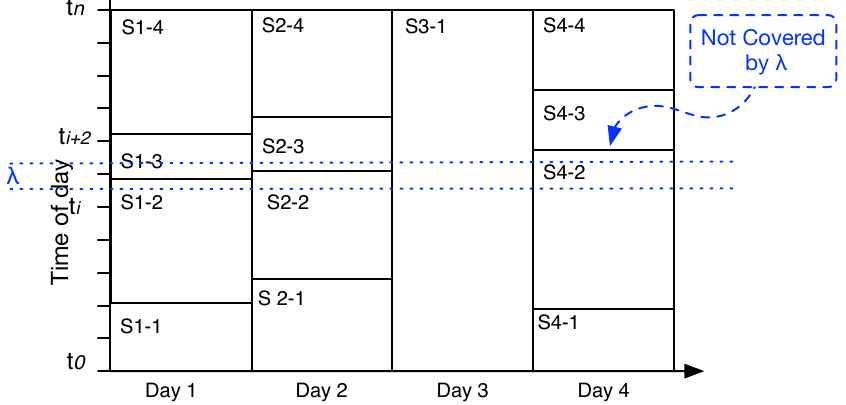
Figure 4. An example of four days with spatio-temporal change points, Day 3 is on a weekend. The fix λ disables the algorithm from recognizing Day 4 events properly in their cluster. In particular, S1-3 , S2-3 and S4-3 should belong to the same cluster. However, by not moving λ , S4-3 can not fit into the cluster of S1-3 and S2-3